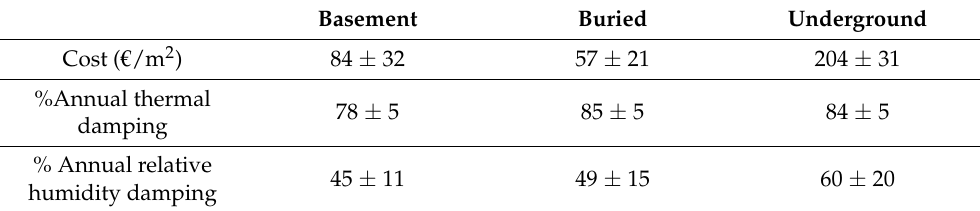
Table 3. Average of cost, thermal, and humidity damping in the basement, buried, and underground